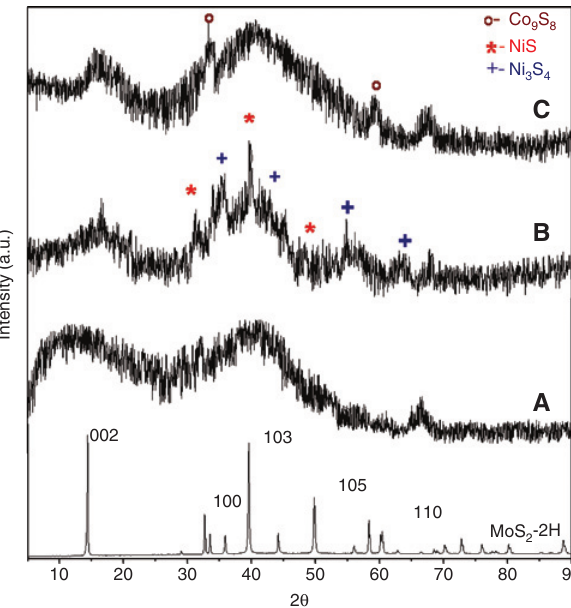
-2H and unsupported nanospheres 2 and (C) CoMoS . 2 2